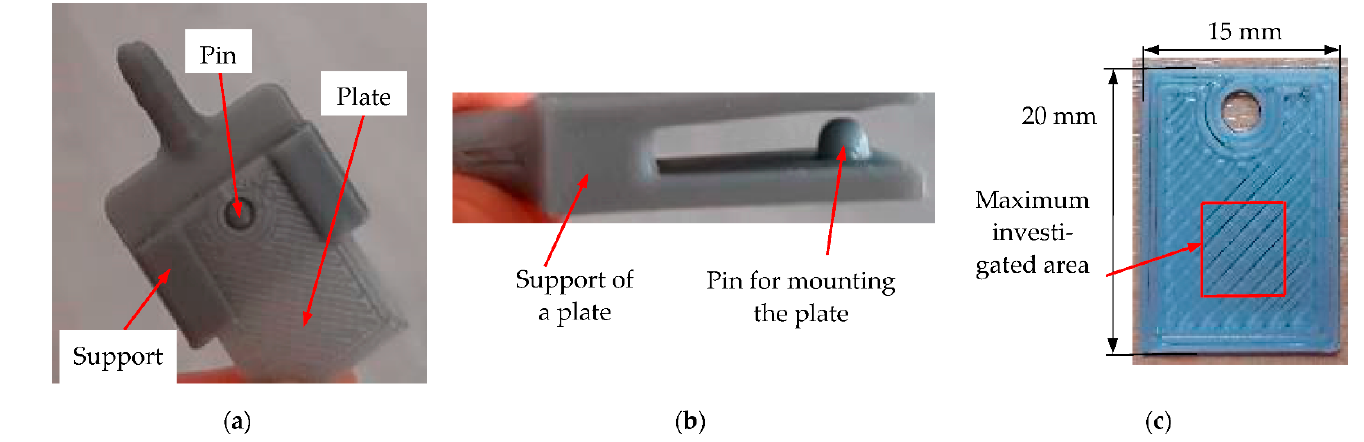
Figure 2. ( a ) Front view of a plate in its support before inserting in the bioreactor; ( b ) lateral view of a plate support, with its mounting pin; ( c ) photo of a plate utilized in the bioreactor (i.e., positioned at the top of the reactor, as shown in Figure 1a), indicating the dimensions of the twelve (identical) plates and the maximum (6 × 6 mm 2 ) selected area for the different SEM and OCT